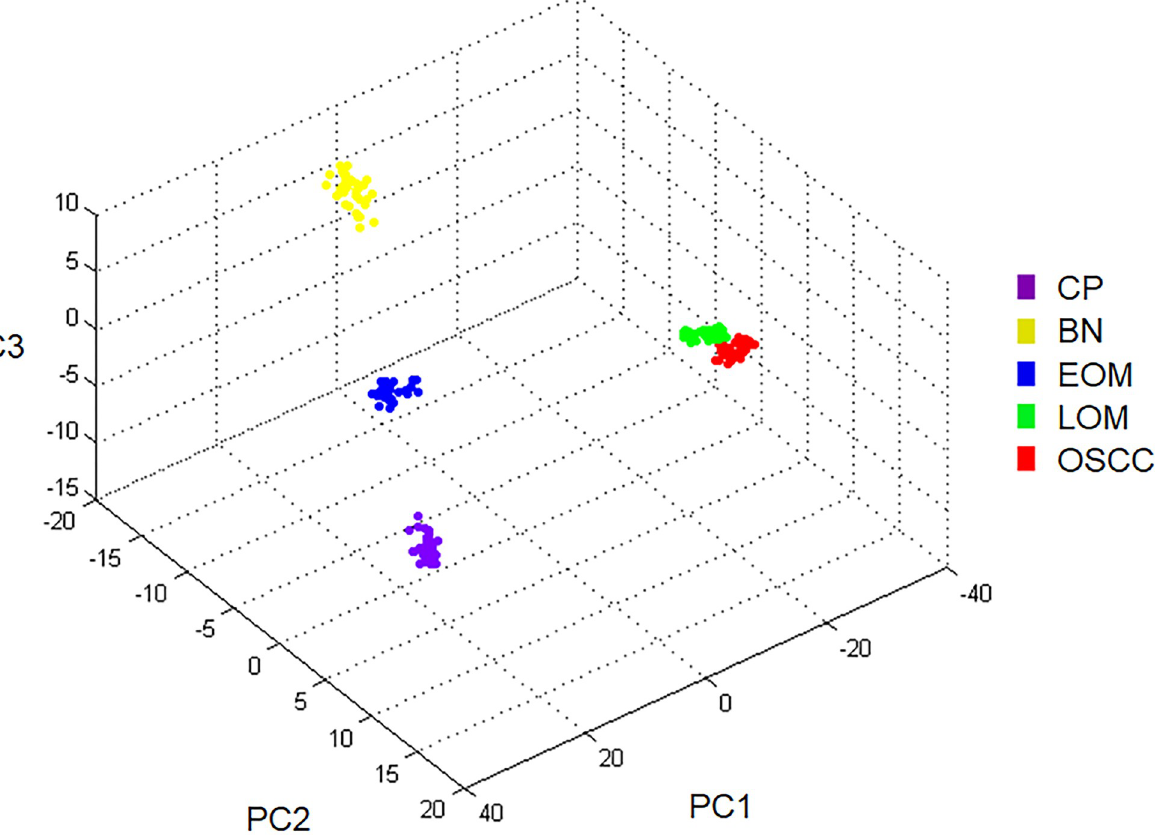
Fig 1. Three-dimensional principal component analysis scatterplot of normal and periodontitis gingiva tissues (CP), benign tumors (BN), early- stage oral melanoma (EOM), late-stage OM (LOM) and oral squamous cell carcinoma (OSCC). Thirty two dots represent replicate in each pooled sample